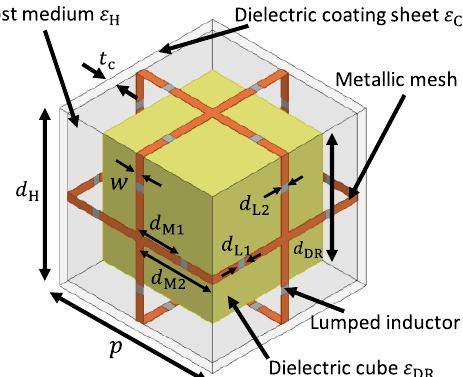
Fig. 1. Schematic of unit cell block of 3-D quasi-isotropic LH metamaterial loaded with the lumped inductor.